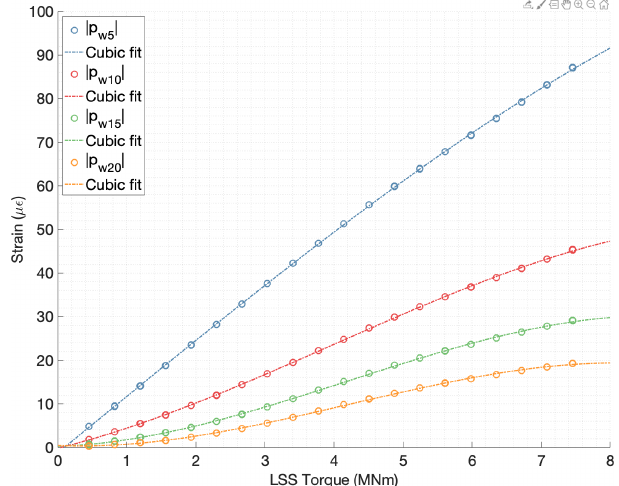
Figure 17. Magnitudes of the 5th, 10th, 15th, and 20th harmonic components of all 54 weighted sensors vs. torque in low-speed